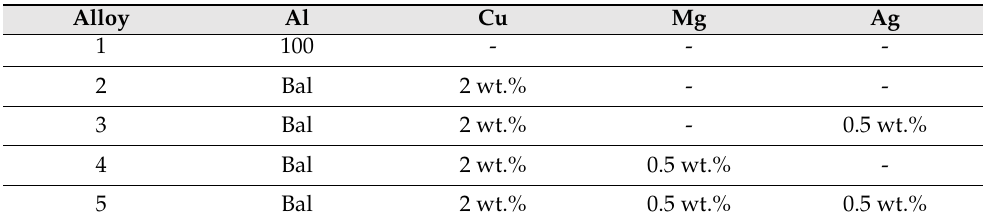
Table 1. Pure Al and four different aluminum alloys composition.